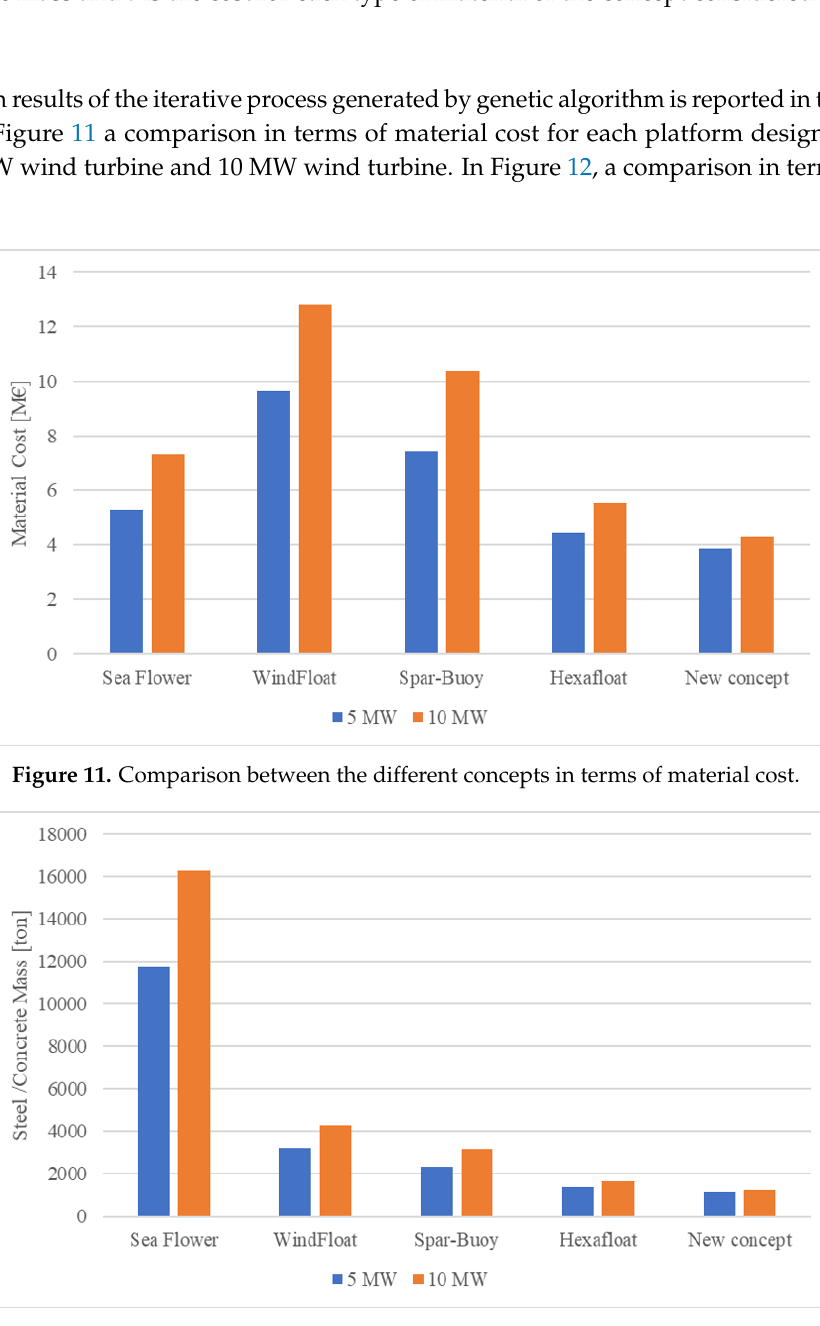
Figure 12. Comparison between the different concepts in terms of